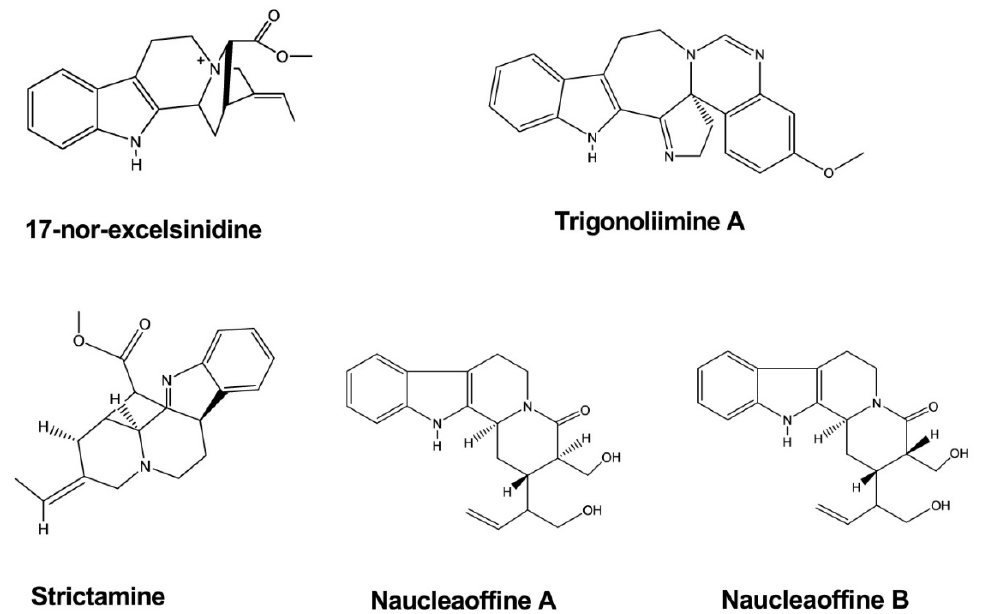
Figure 3. Antiviral activity of indole alkaloids.